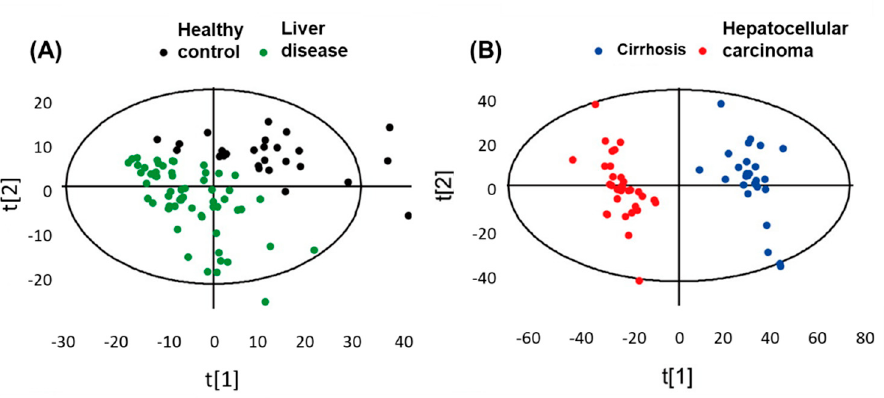
Figure 5. ( A , B ) Plot of cell metabolic discrimination by supervised PLS-DA analysis. Pattern recog- nition of healthy control (HC) group and liver disease (LD) groups, which included cirrhosis (CIR) and HCC samples. Adapted with permission from [67], Copyright 2014, American Chemical Soci- ety.